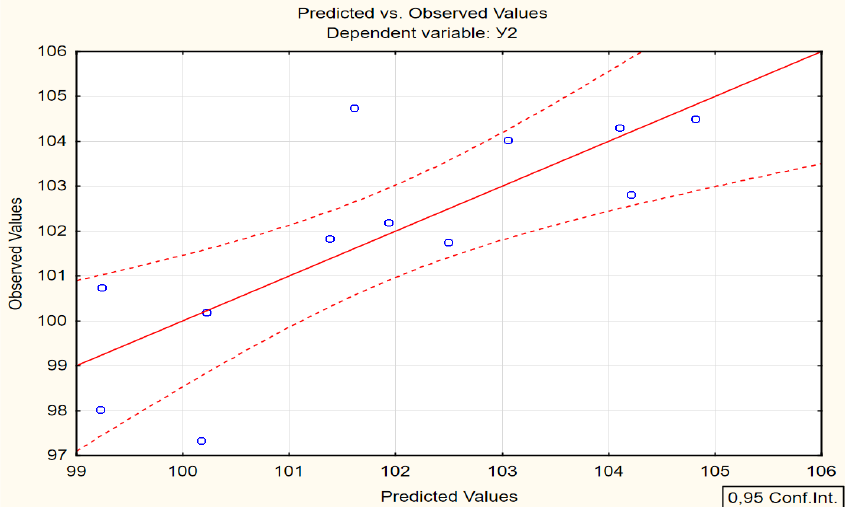
Figure 5. Observed and predicted values for the dependent variable (Y2).